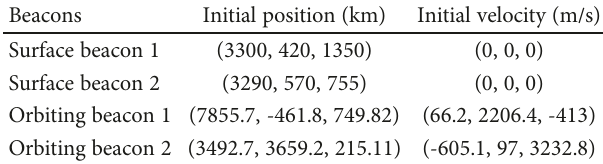
Table 2: Positions and velocities of